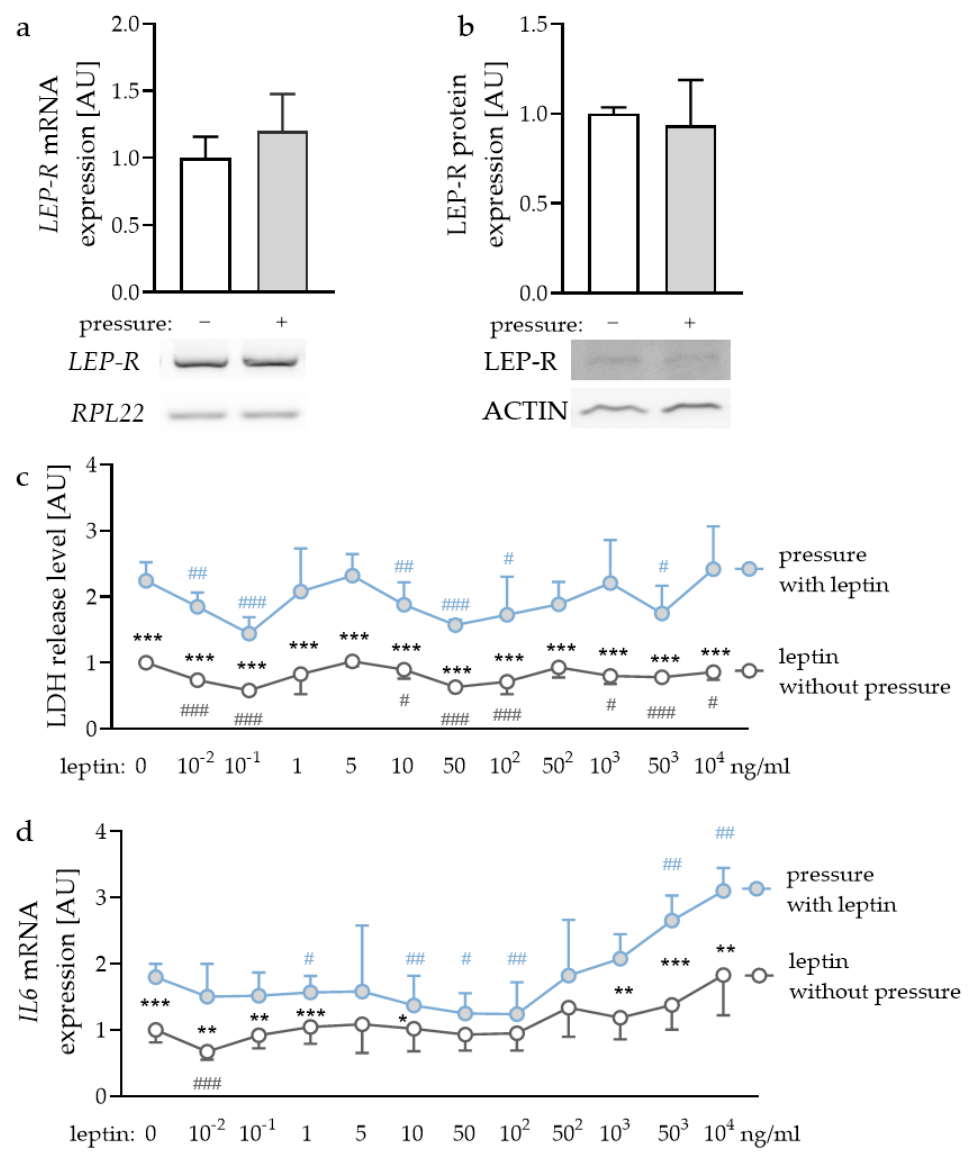
Figure 1. Gene ( a ) and protein expression ( b ) of the leptin receptor (LEP-R) in PDLF without and with compressive strain compared to the loading controls ribosomal protein L22 ( RPL22 ) or ACTIN. Impact of different leptin concentrations without and with compressive strain on lactate dehydrogenase (LDH) release ( c ) and interleukin-6 ( IL6) gene expression ( d ). n ≥ 6; Statistics: ( a , b ): Mann-Whitney U test; ( c , d ): ANOVA followed by unpaired t tests. * Pressure effect: comparison between control and pressure at the respective leptin concentration; * p < 0.05; ** p < 0.01; *** p < 0.001. # Leptin effect: comparison between respective leptin concentration and control or pressure without leptin addition. # p < 0.05; ## p < 0.01; ### p <